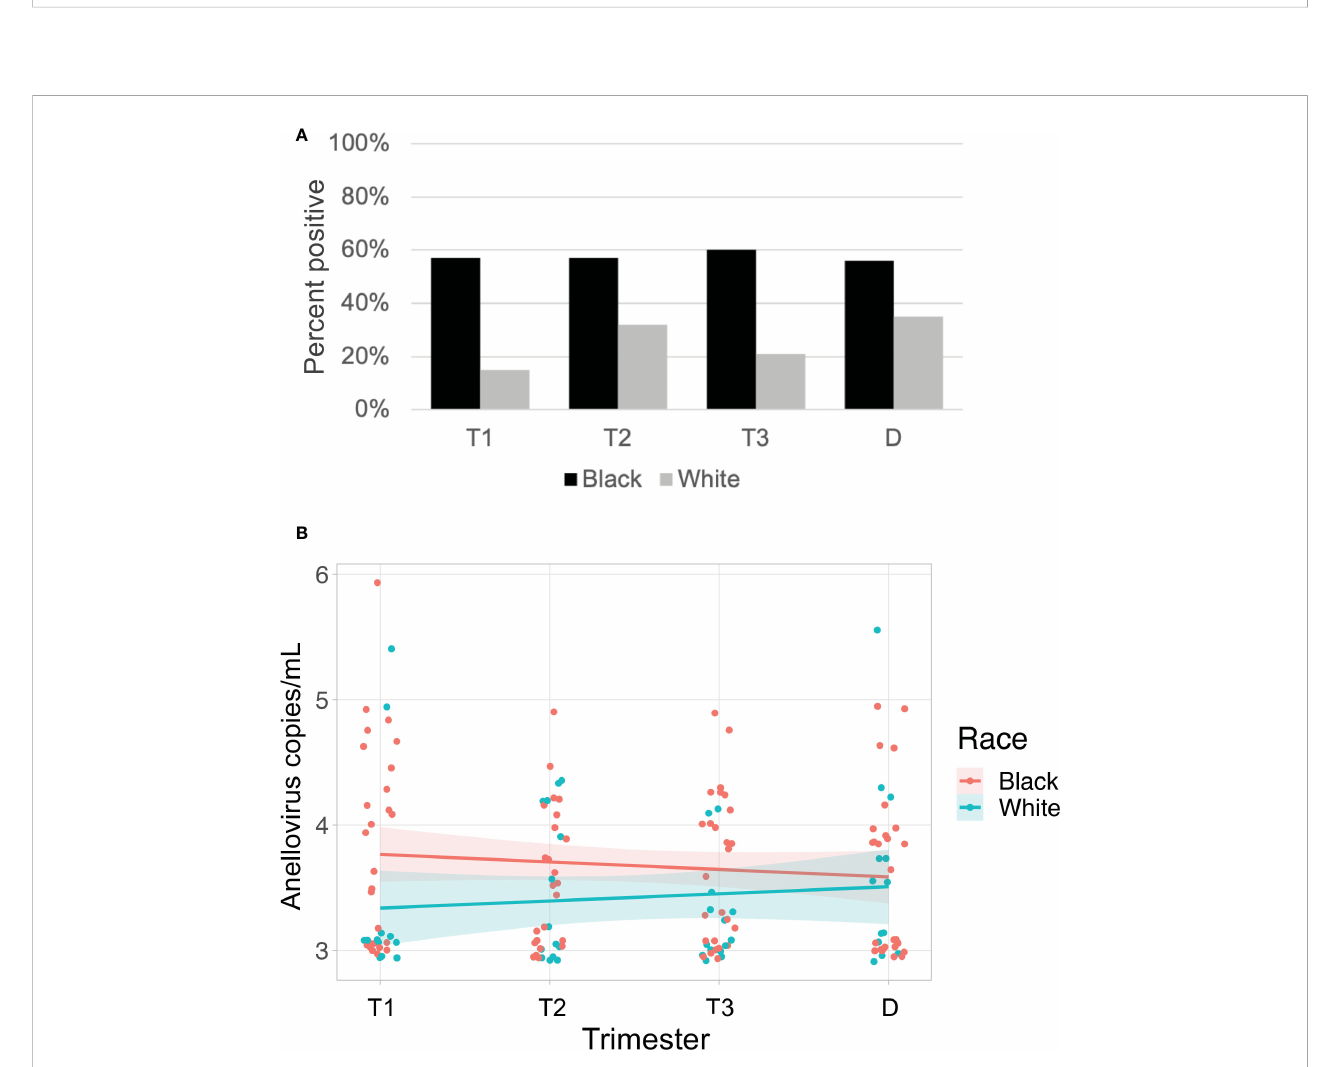
FIGURE 6 Anellovirus positivity is higher in Black subjects than White subjects. In (A) , the percentage of maternal samples positive by PCR assay (y-axis) is shown for each time point (x-axis). Results from Black subjects are indicated by black bars; White subjects are indicated by gray bars. In (B) , only subjects who were positive for anellovirus in at least one of their samples are included. The anellovirus genome copies per mL (y-axis) is shown for each time point (x-axis), and the fi tted line is plotted with the 95% con fi dence interval shaded. Black subjects are plotted in pink, and White subjects are in blue. Black and White groups differed by positivity (P<0.001) but not by viral load (P=0.1) by generalized linear mixed effects model. T1, Trimester 1; T2, Trimester 2; T3, Trimester 3; D,